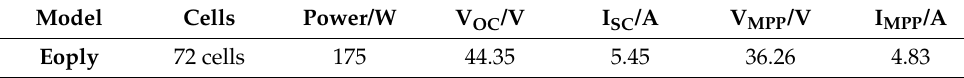
Figure 6. PV plant on Duques de Soria campus of the University of Valladolid. Table 1. Technical characteristics of the PV module.